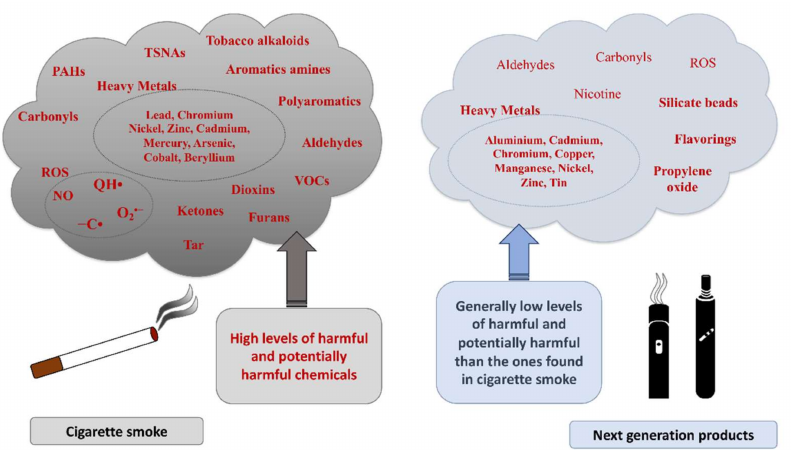
Figure 2. Chemical compounds generated by cigarette smoke and next-generation products